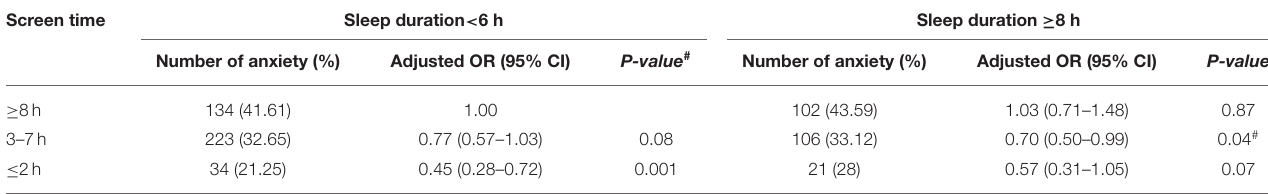
TABLE 3 | Odds ratios (95% CI) associated with the interaction of screen time and sleep duration on anxiety among pregnant women*.